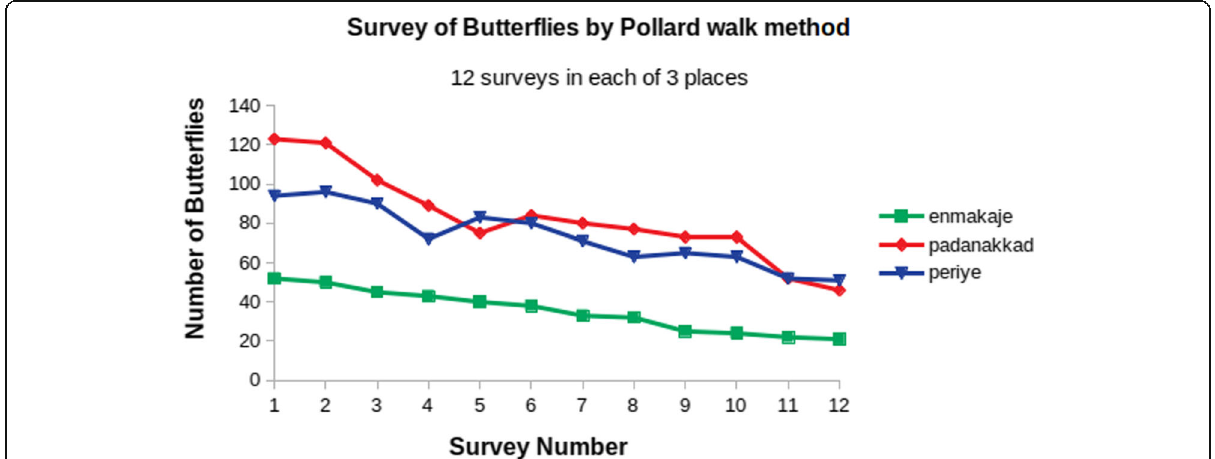
Fig. 2 Twelve surveys conducted using “ Pollard walk ” method in all the three study areas viz., Enmakaje, Padanakkad, and Periye. It represents a decrease in the butterfly ’ s number from August 2018 to September 2018.